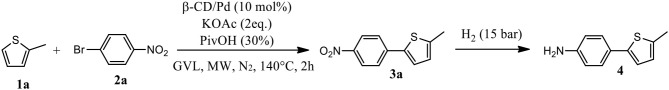
Sequential direct arylation and reduction reactions.